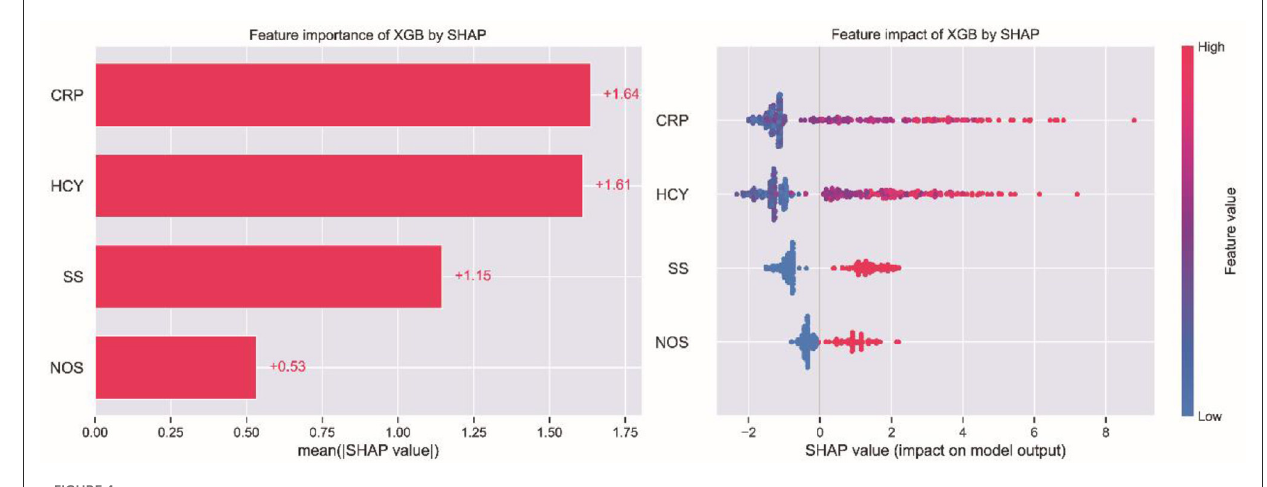
FIGURE4 Patient clinical feature importance of XGB.